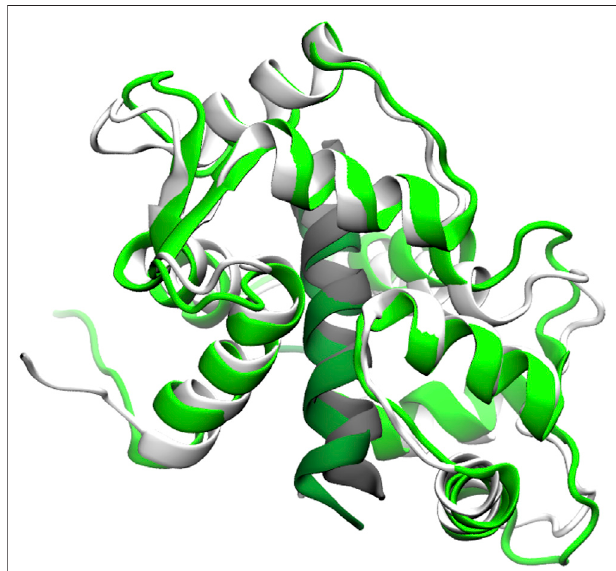
FIGURE 4 | Superposition of a typical model (green) from the Trial3 ensemble with the reference structure (white). Peptide is shown in dark green and grey respectively. The superposition was over residues 4 – 146 of calmodulin plus the peptide. The backbone RMSD of this structure is 2.8 Å,whichisnearthemeanoftheensemble.StructureswithRMSDsaslow as 1.6 Å are